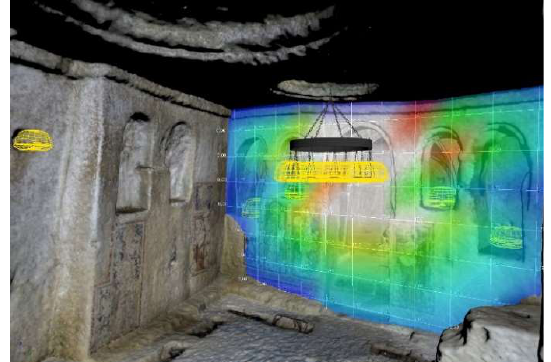
Figure 13. 3D Studio Max Sw. Lightmeter for lighting analysis. Natural and artificial lighting on the front wall.